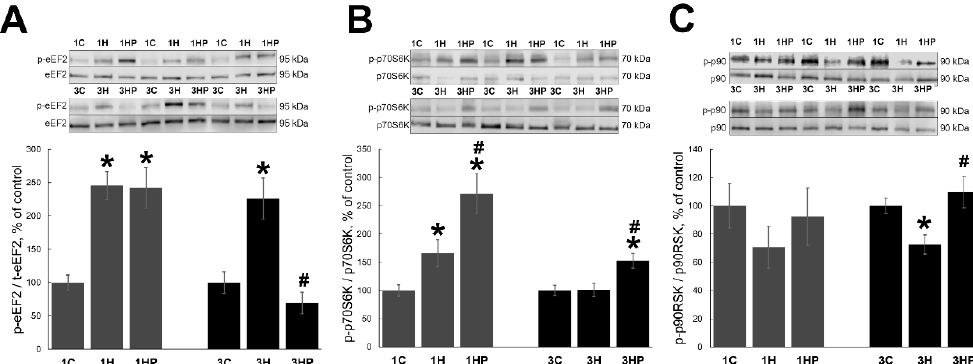
Figure 4. Evaluation of the p-eEF2 ( A ), p-p70S6K ( B ) and p-p90RSK ( C ) content in soleus muscles of non-treated control rats (1C and 3C), rats after 1 and 3 days of unloading (1HS and 3HS), and 1 and 3 days of HS with PRB inhibitor (1HP and 3HP). Values are normalized to the level of total eEF2 (A), total p70S6K ( B ) and total p90RSK ( C ) in each sample. n = 8. * indicates a significant difference from the control, # indicates a significant difference from the HS group, p < 0.05.